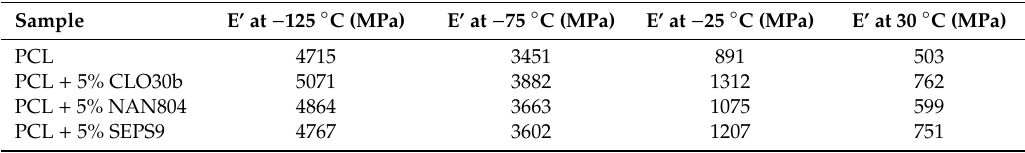
Table 2. E’ value of nanocomposites of PCL at different temperature ranges. [37], Reproduced with permission from Fukushima K, Mater. Sci. Eng. C; published by Elsevier, 2009.